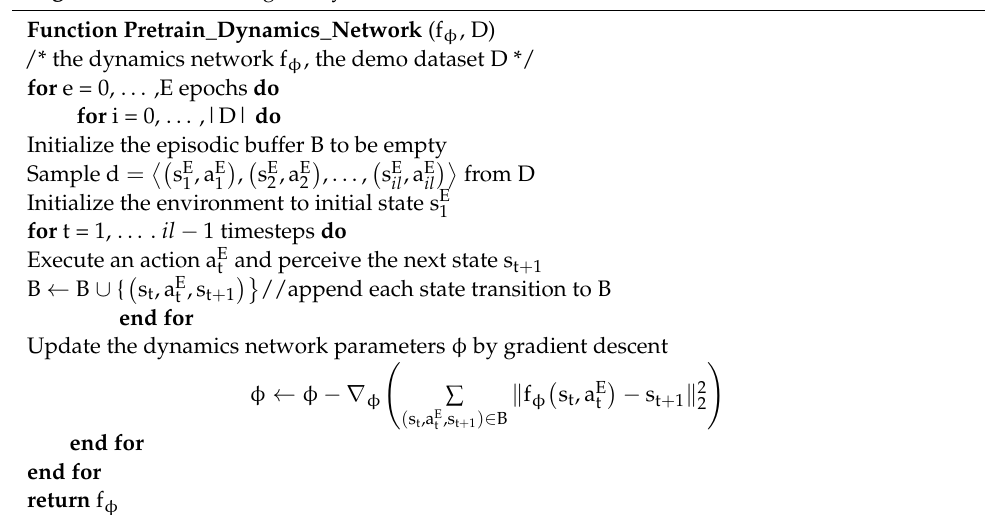
Algorithm 4. Pretraining the dynamics